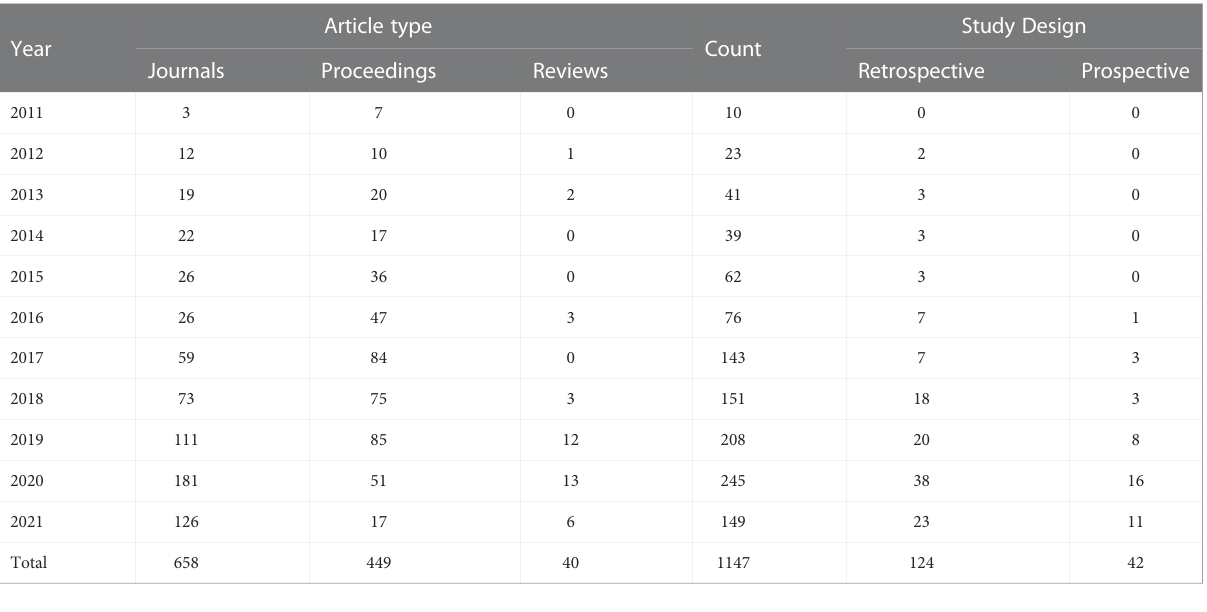
Top 10 articles ranked by annual citations (C/Y) Gulshan et al. (14) Ting et al. (27)